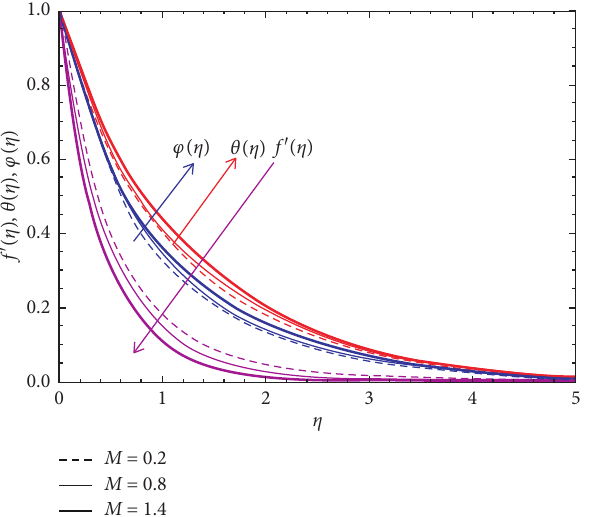
Figure 4: Effects of magnetic parameter on velocity gradient, temperature, and concentration profiles.